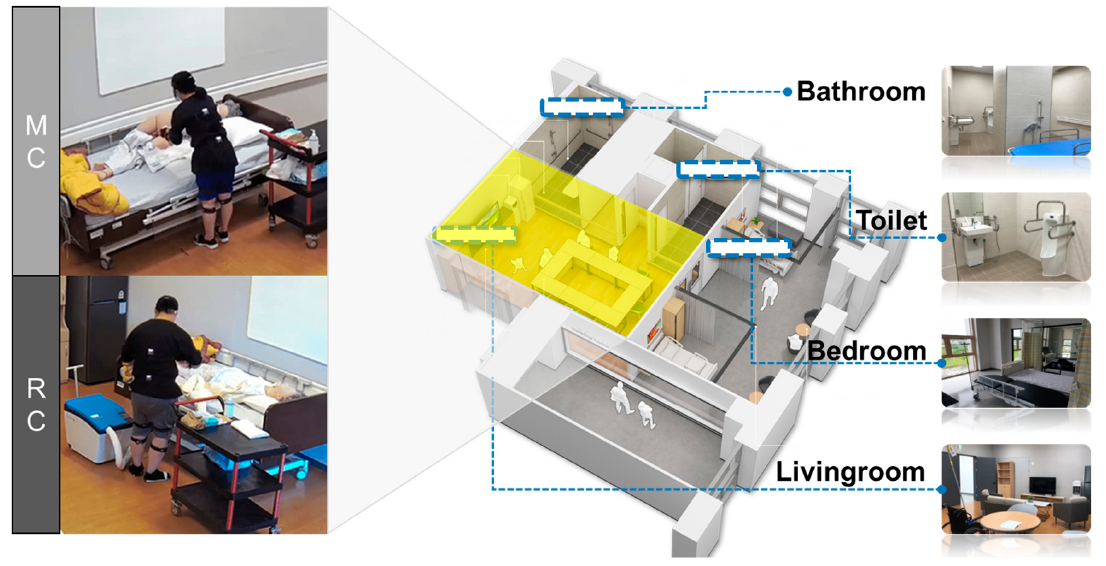
Figure 2. The smart care space simulates a nursing home.